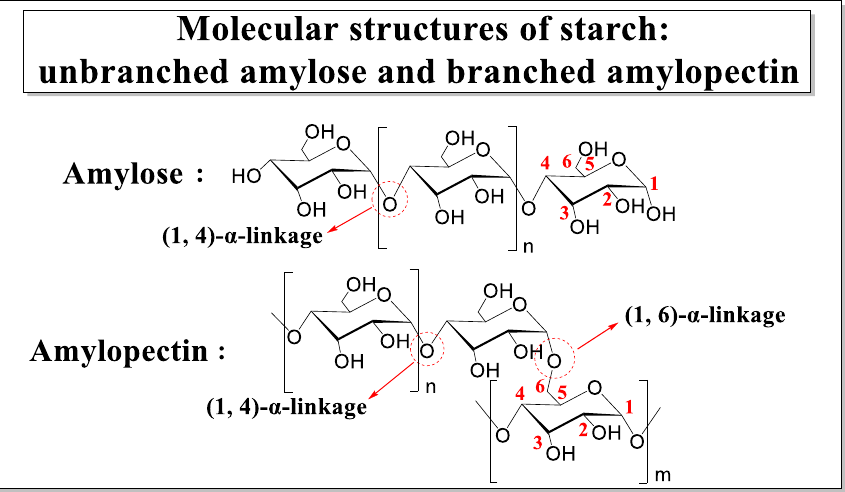
Figure 1. Two different molecular structures of starch: unbranched amylose and branched amylopectin.